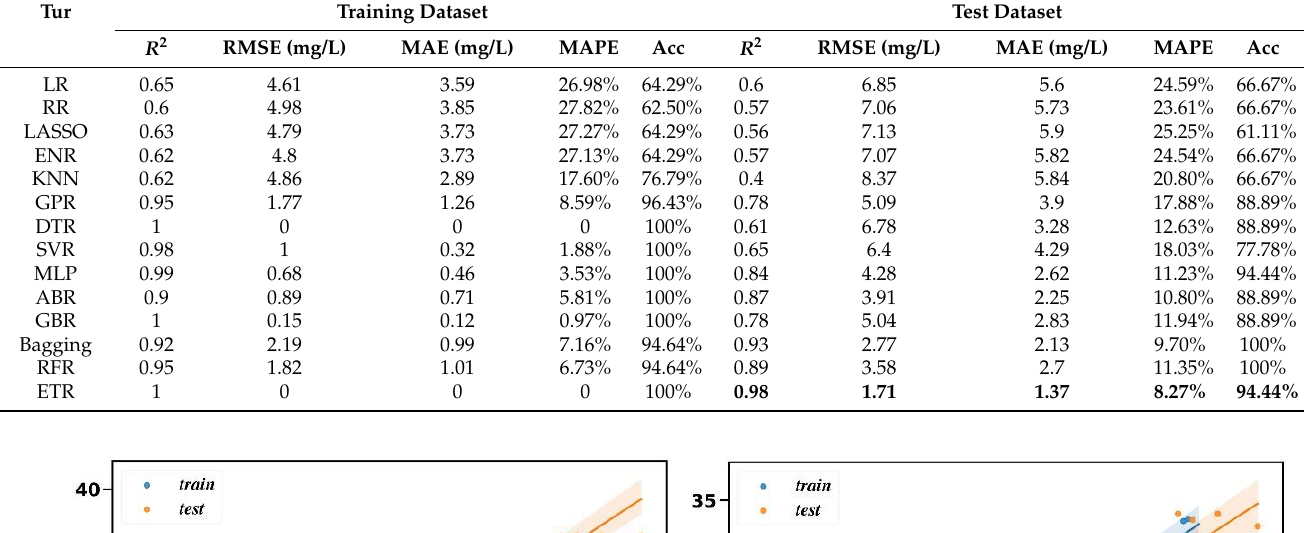
Table 6. Performance of fourteen models on turbidity training dataset and test dataset.